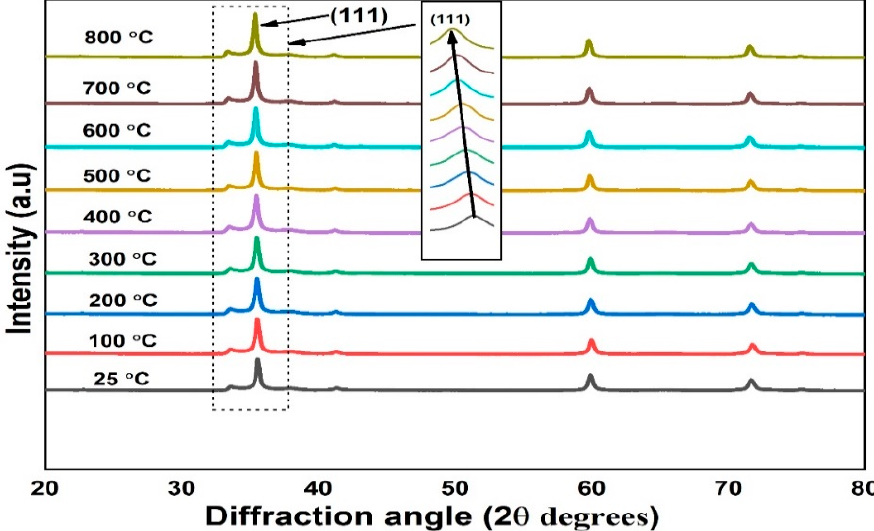
Figure 4. XRD patterns of 3C-SiC under different temperatures.